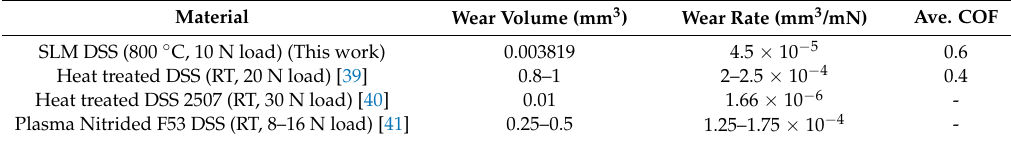
Figure 7. Friction and wear behaviour of post heat treated SLM 2507: ( a ) coefficient of friction (COF) versus sliding distance, ( b ) 3D view of wear track and 2D wear track profile showing wear depth; SEM images of wear track using ( c ) secondary electron mode and ( d ) backscattered electron mode. Table 3. Sliding wear properties of post heat treated SLM 2507 versus conventional post heat treated DSS.